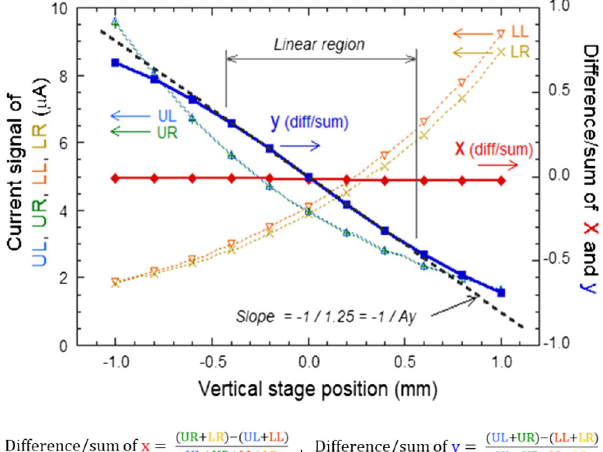
FIG. 23. Results of the scan measurement with scan steps of 0.2